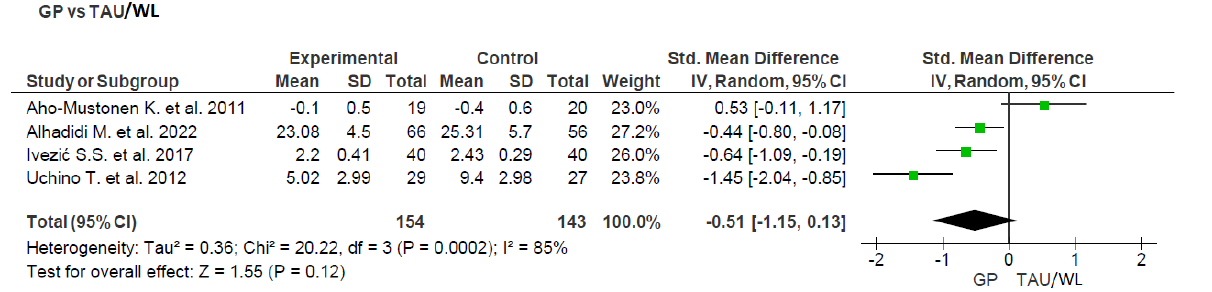
Figure 4. Subgroup analysis of Group Psychoeducation (GP) in comparison to Treatment as Usual